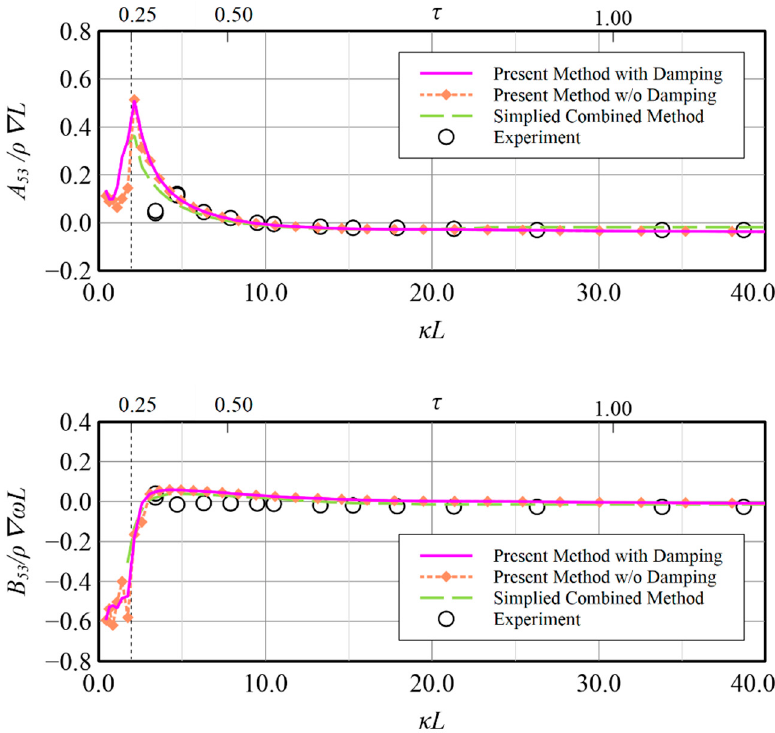
Figure 16. Heave-induced-pitch added mass and damping coefficient at F r = 0.18.